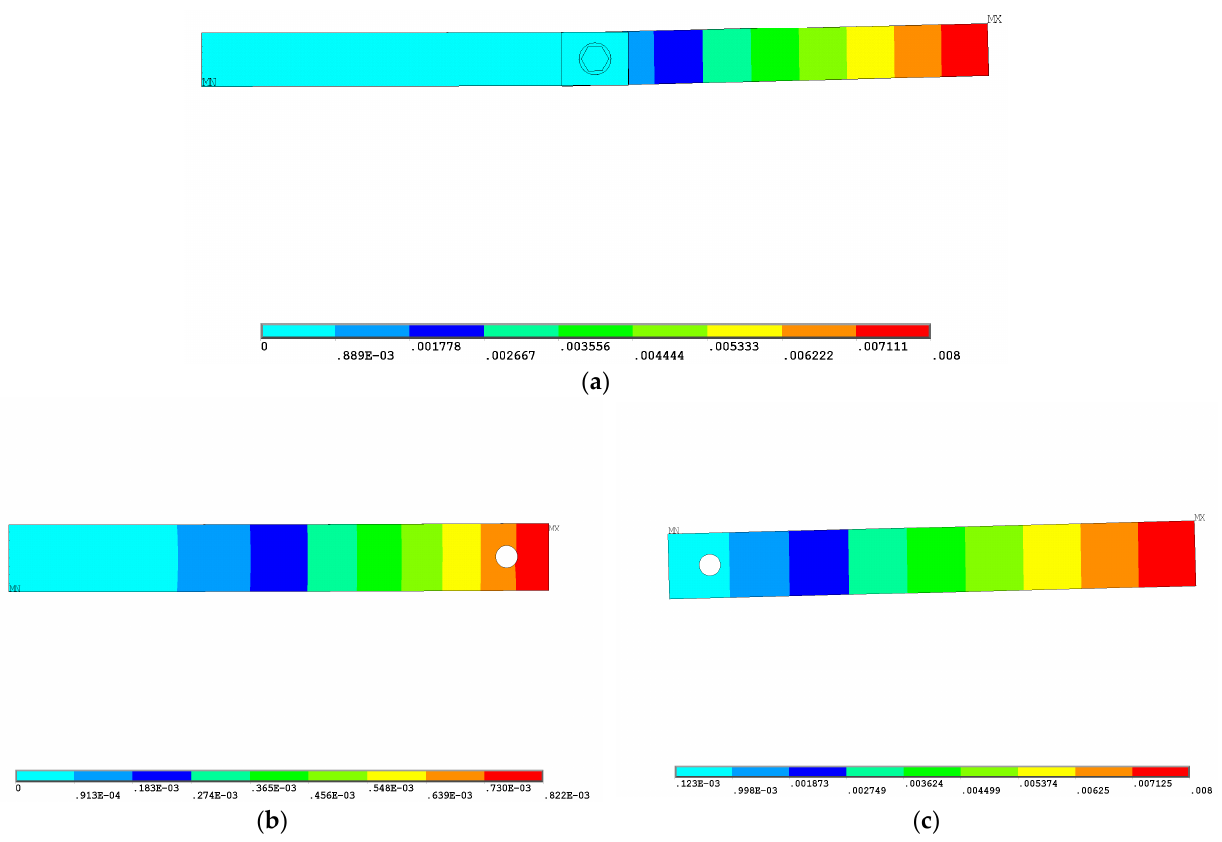
Figure 10. The transverse displacement: ( a ) Overall bolt-jointed beam; ( b ) The beam with a fixed end; ( c ) The beam with a free end.